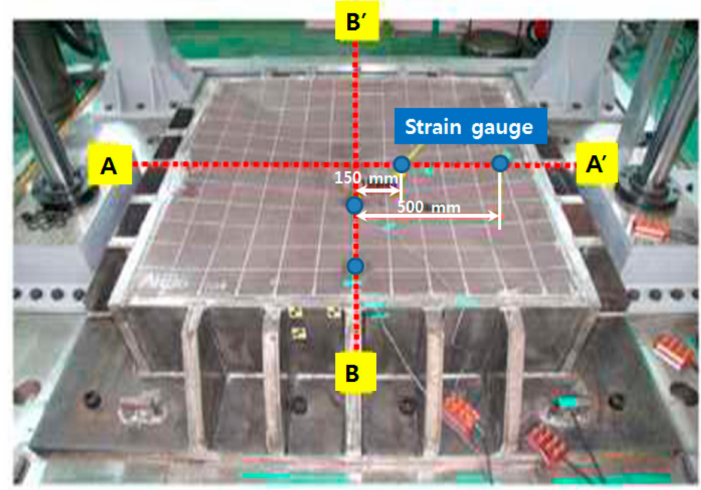
Figure 13. Test specimen (AH36, 1200 × 1200 × 10 mm).